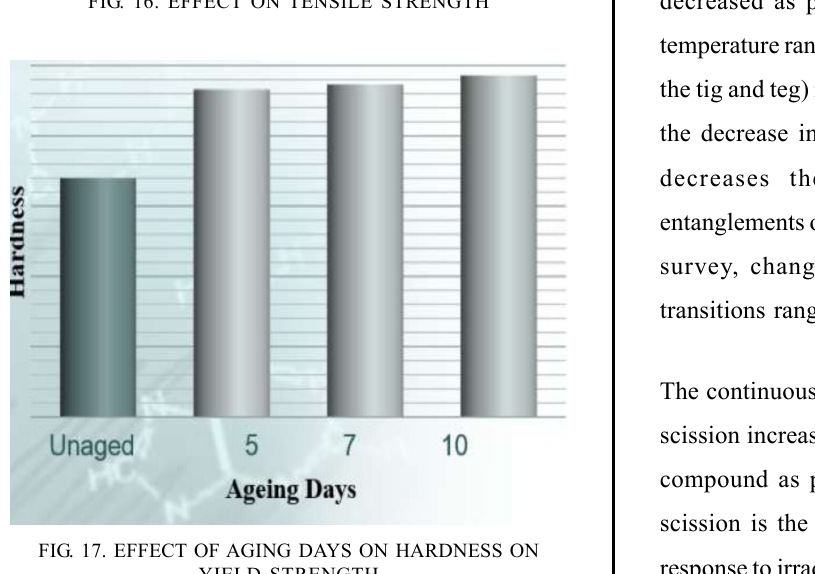
FIG. 16. EFFECT ON TENSILE